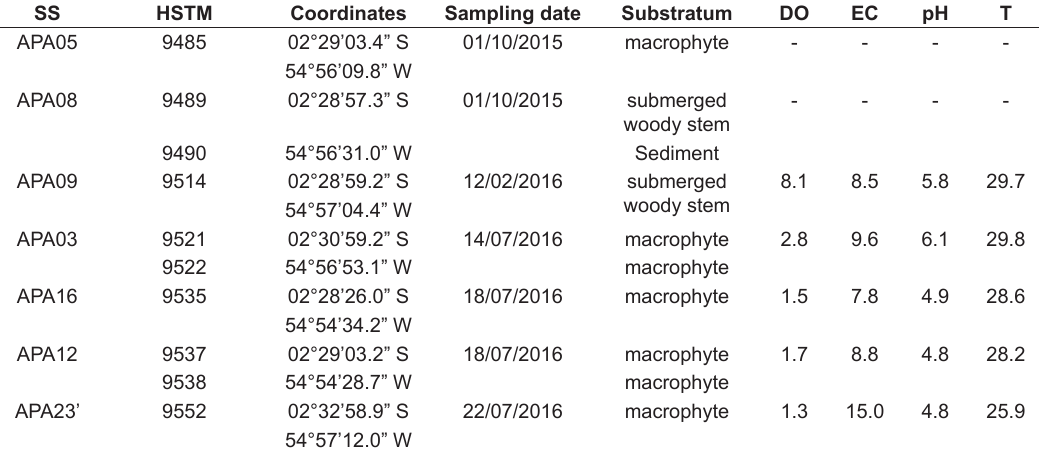
Table 1. Data on water parameters for sampling stations (SS). HSTM: deposit number in the HSTM-Algas herbarium; DO: dissolved oxygen (mg L -1 ); EC: electrical conductivity (μS cm -1 ); T: water temperature